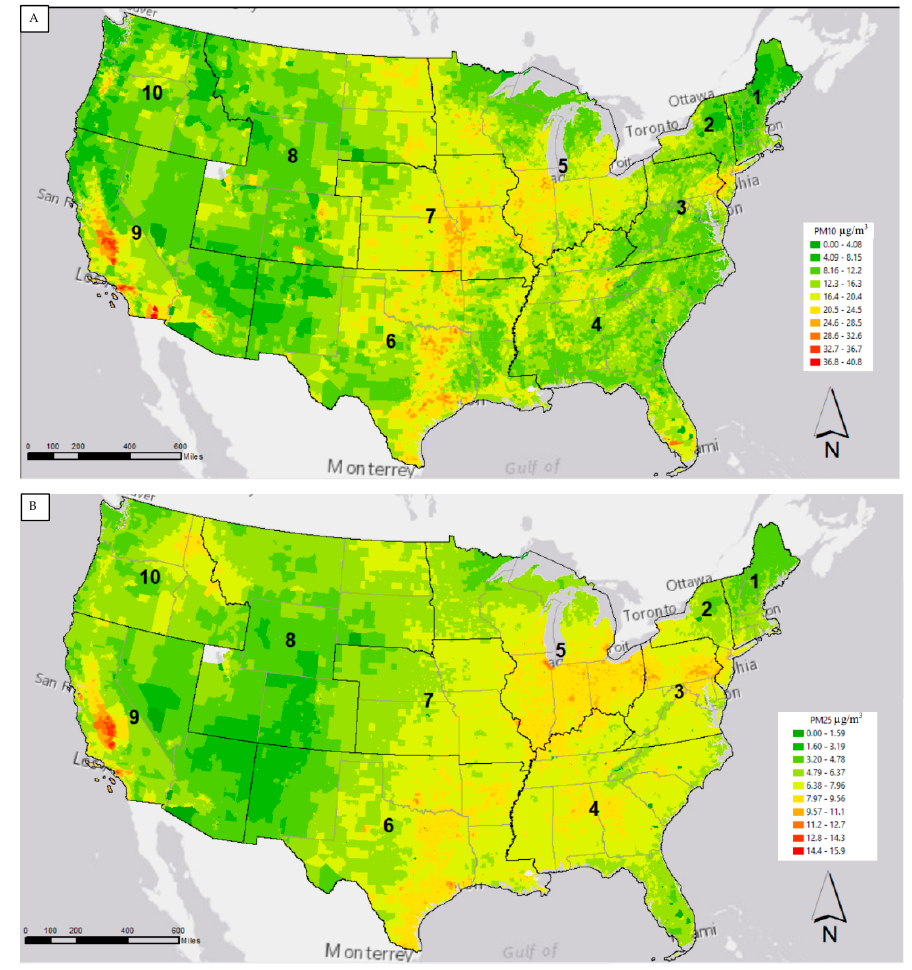
Figure 2. Census tract-level estimates of ( A ) PM 10 and ( B ) PM 2.5, measured in micrograms per cubic meter, for the year 2015 color-coded by deciles.